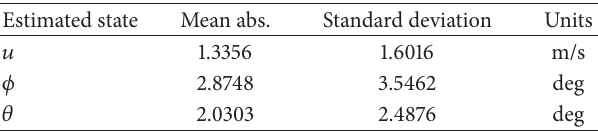
Table 9: Simplified formulation error statistics for Flight #2 with range state.